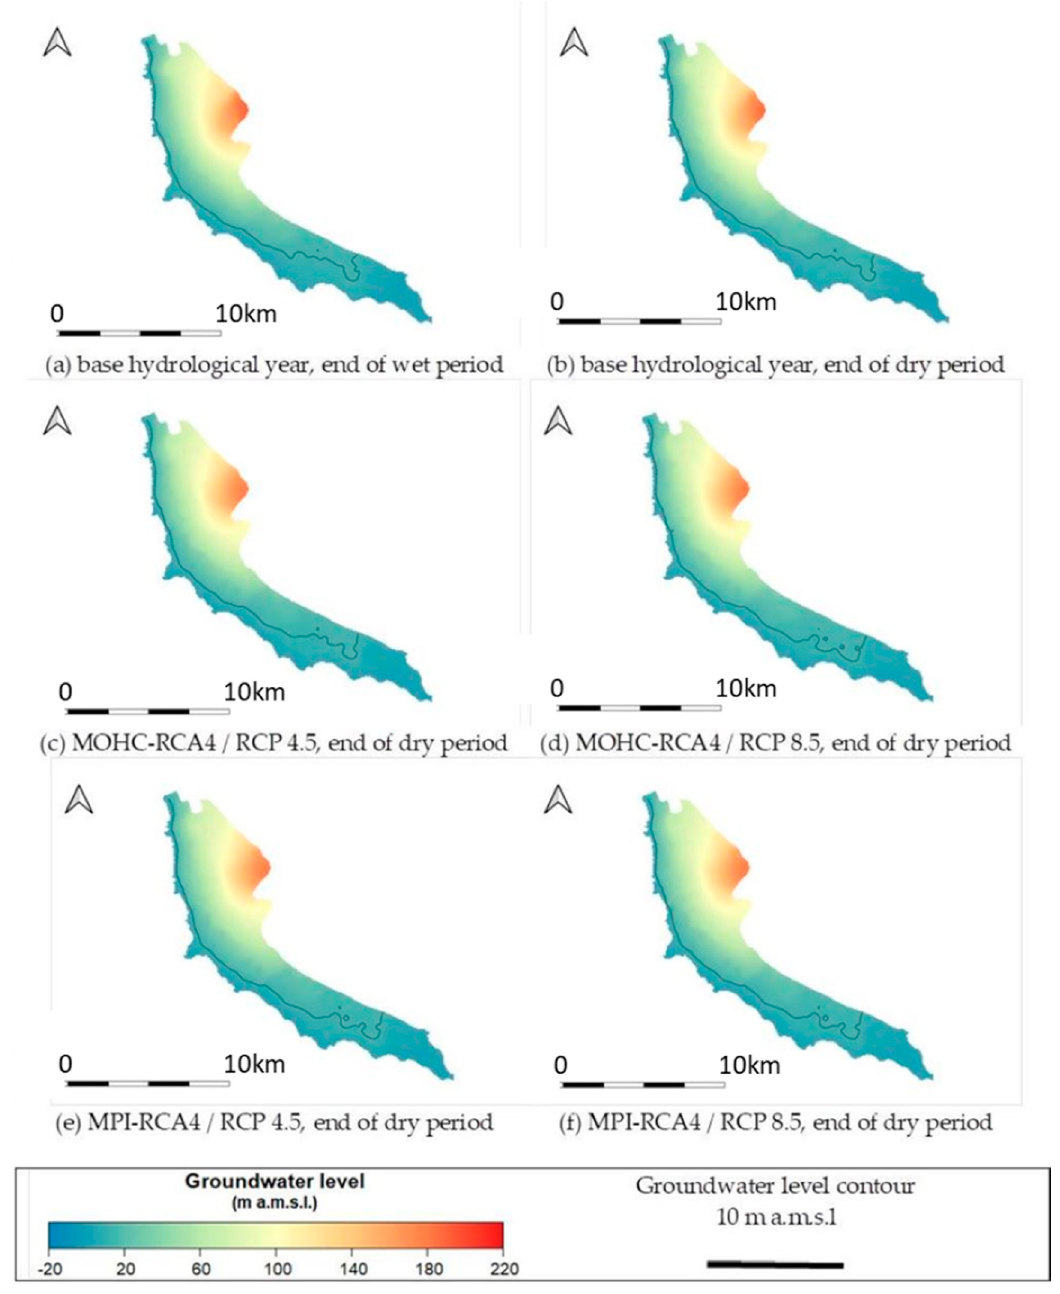
Figure 6. Groundwater level in Acheleia aquifer—Results of numerical simulations at the end of dry period.